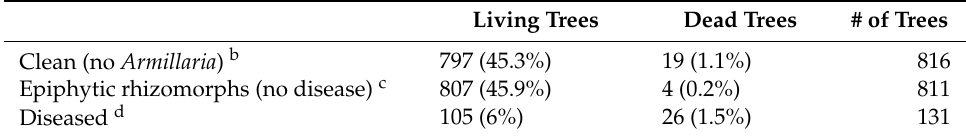
Table 2. The proportion of Armillaria isolates associated with diseased or apparently healthy (epiphytic rhizomorphs only) trees from among 1758 western white pine ( Pinus monticola ). a Within the Ida Creek plantation (0.8 ha) at the Priest River Experimental Forest, Idaho,